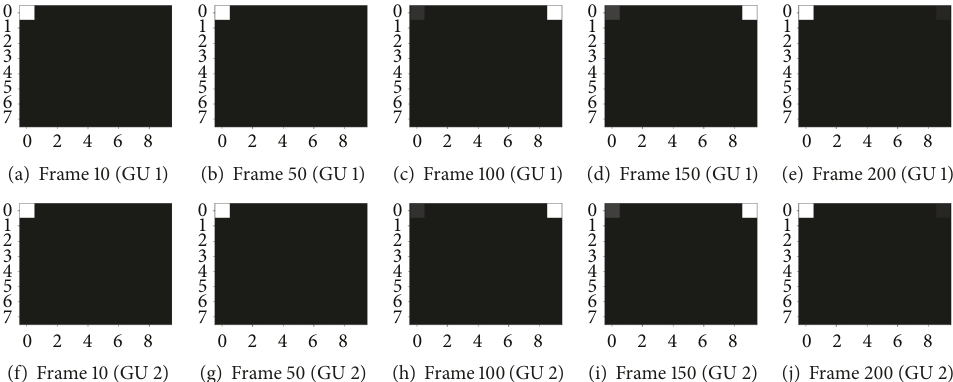
Figure 18: Representation in GU Units (Layer 3) (Crazy turn).